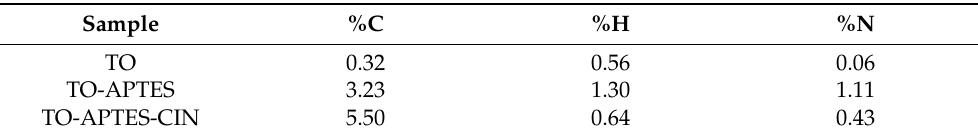
Table 1. Elemental analysis (in weight percentage) of TO, TO-APTES, and TO-APTES-CIN by CHN